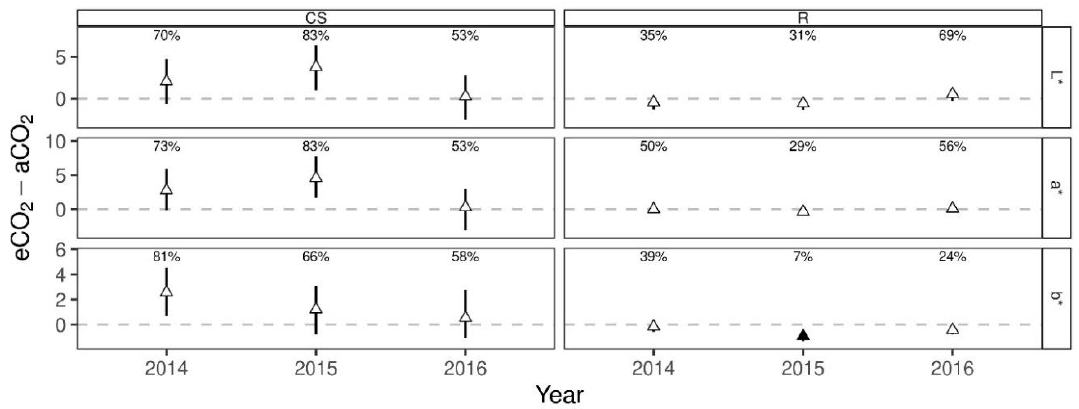
Figure 6. Posterior predicted difference (median and 50% HDI) between eCO 2 and aCO 2 for each measurement year from Bayesian generalized linear mixed effects models on CIELab parameters of Cabernet Sauvignon (CS) and Riesling (R). Percentages represent the probability of eCO 2 -aCO 2 > 0. Filled symbols indicate “significant differences”, if the probability is >90% (positive difference) or <10% (negative difference).